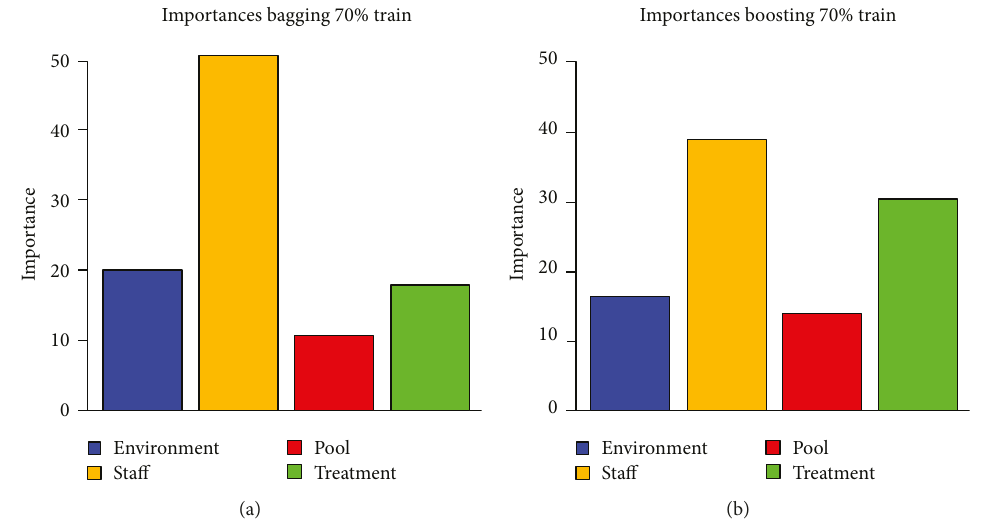
Figure 5: Importance of each of the variables studied for classi fi cation. Table 7: Means of the importance, standard deviations, and Student t for bagging and